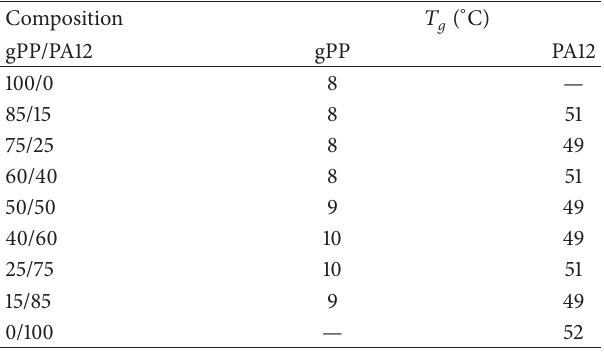
Table 2: Melting and crystallization temperatures of gPP and PA12 in the blends. The average standard deviation is 0.5 ∘ C.